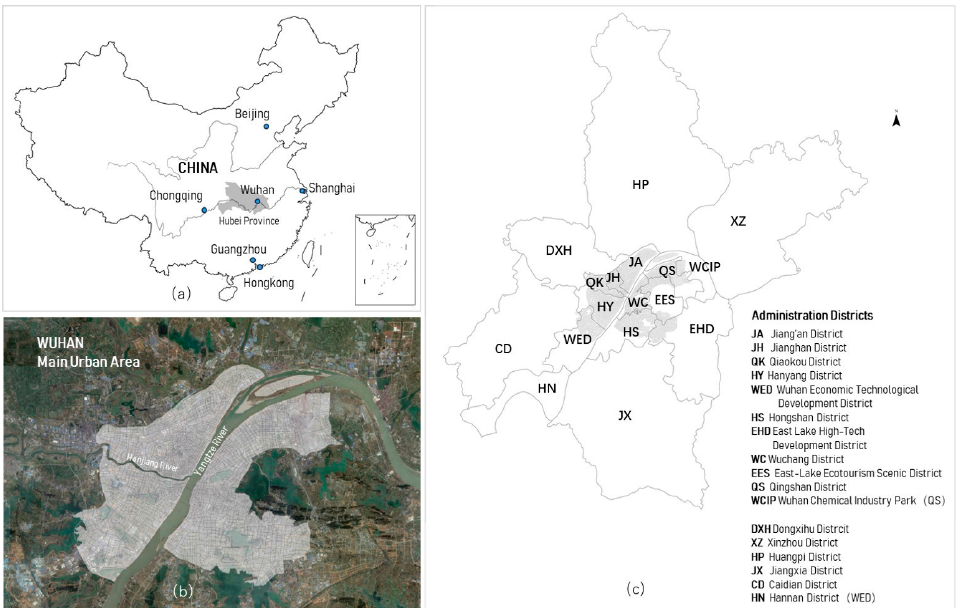
ISPRS Int. J. Geo-Inf. 2020 , 9 , x FOR PEER REVIEW Figure 2. Map of the study area in Wuhan, China: ( a ) the geographic location of the Wuhan, China; ( b ) the main urban area of Wuhan (MUA); and ( c ) administrative districts of Wuhan.